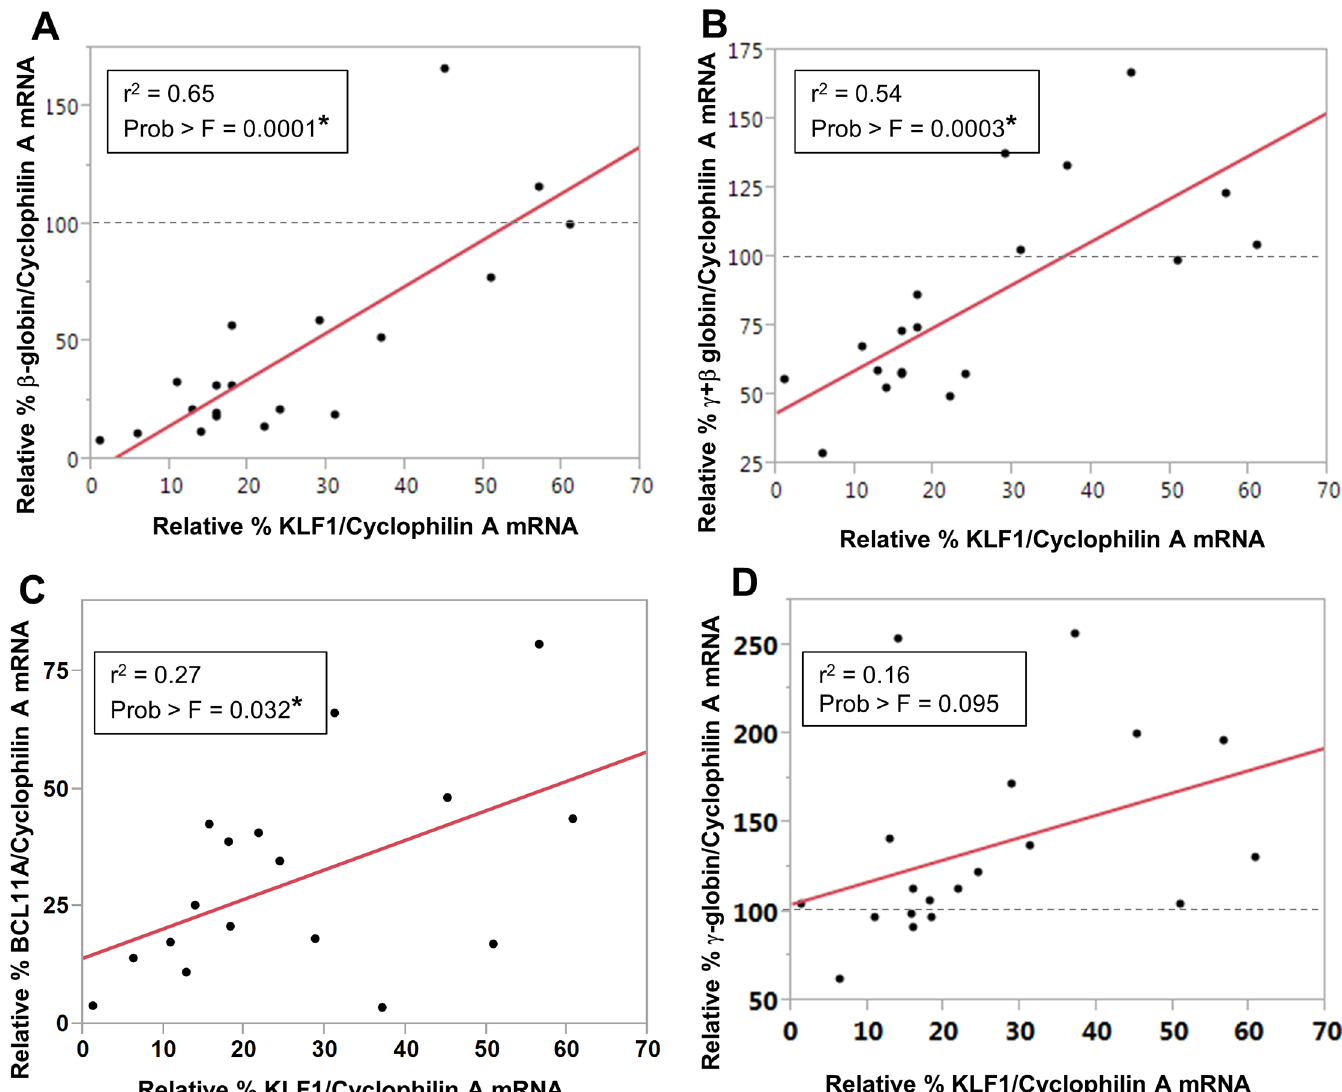
Fig 4. KLF1 regulates β -globin, total globin and BCL11A expression in UCB erythroblasts. The amount of KLF1, β -globin, γ -globin and BCL11A mRNA was measured by qRT-PCR and normalized to Cyclophilin A mRNA. The fold change in expression of these genes in KLF1 shRNA-treated samples was calculated by setting the value in Scr shRNA controls to 100. Each point on the Pearson ’ s correlation plots represents a biological replicate, i.e. cells obtained from a different umbilical cord blood sample. Three of the samples were infected with the K1V1 shRNA, and the remaining samples (the majority) were infected with the K1V2 shRNA. (A) A strong, positive correlation was observed between the amounts of KLF1 and β -globin mRNA (N = 19, r 2 = 0.65, Prob > F = 0.0001); (B) The amount of total globin ( γ + β ) expression positively correlates with residual KLF1 mRNA (N = 19, r 2 = 0.54, Prob > F = 0.0003) (C) There is a modest positive correlation between the amounts of KLF1 and BCL11A mRNA (N = 17, r 2 = 0.27, Prob > F = 0.032). (D) There is no linear relationship between the amounts of KLF1 and γ -globin mRNA (N = 19, r 2 = 0.16, Prob > F =